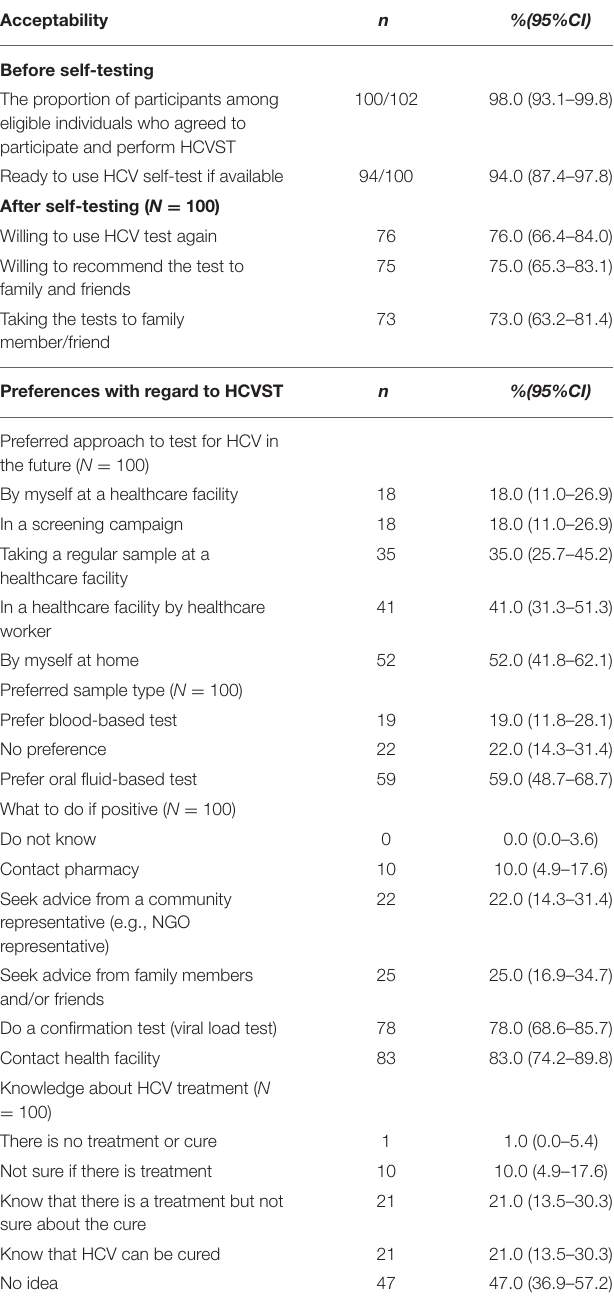
TABLE 4 | Participant views and preferences regarding HCVST, an observational study in China,